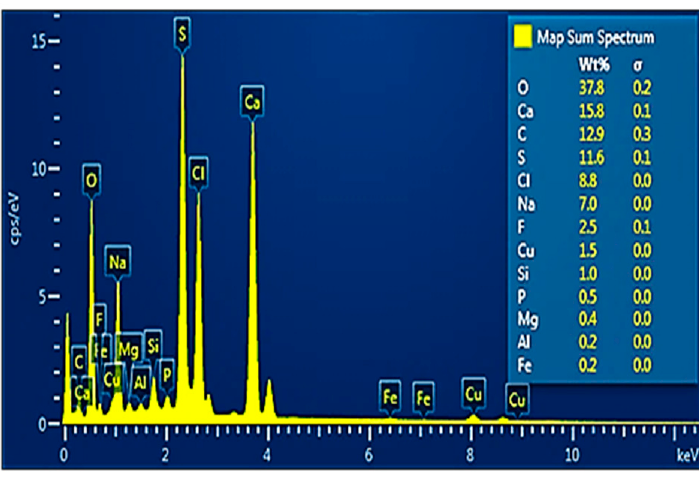
Figure 3. EDS analysis of waste before treatment.